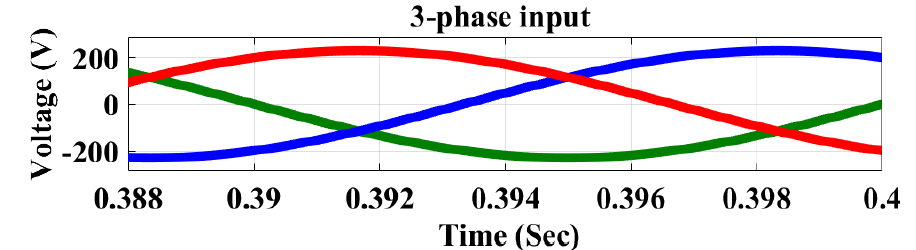
Figure 15. Three phase input voltage for FSTPI